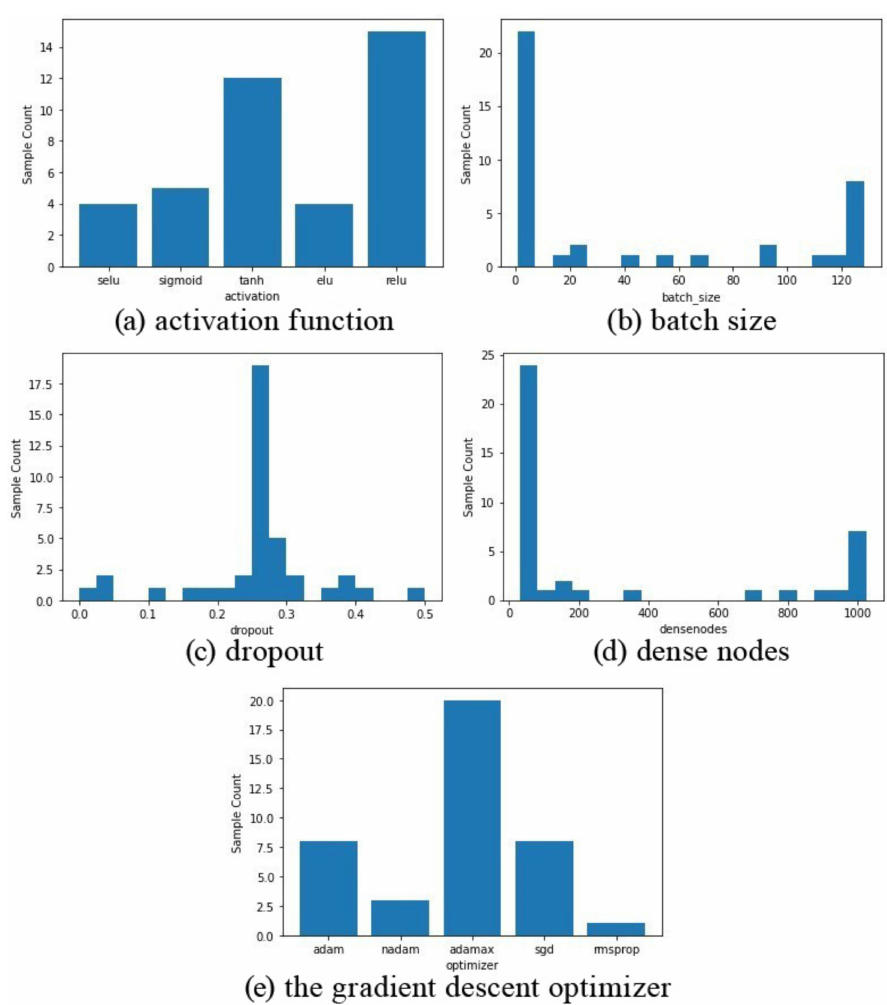
Figure 13. Count of the hyperparameters selected. ( a ) activation function; ( b ) batch size; ( c ) dropout; ( d ) dense nodes; ( e ) the gradient descent optimizer.